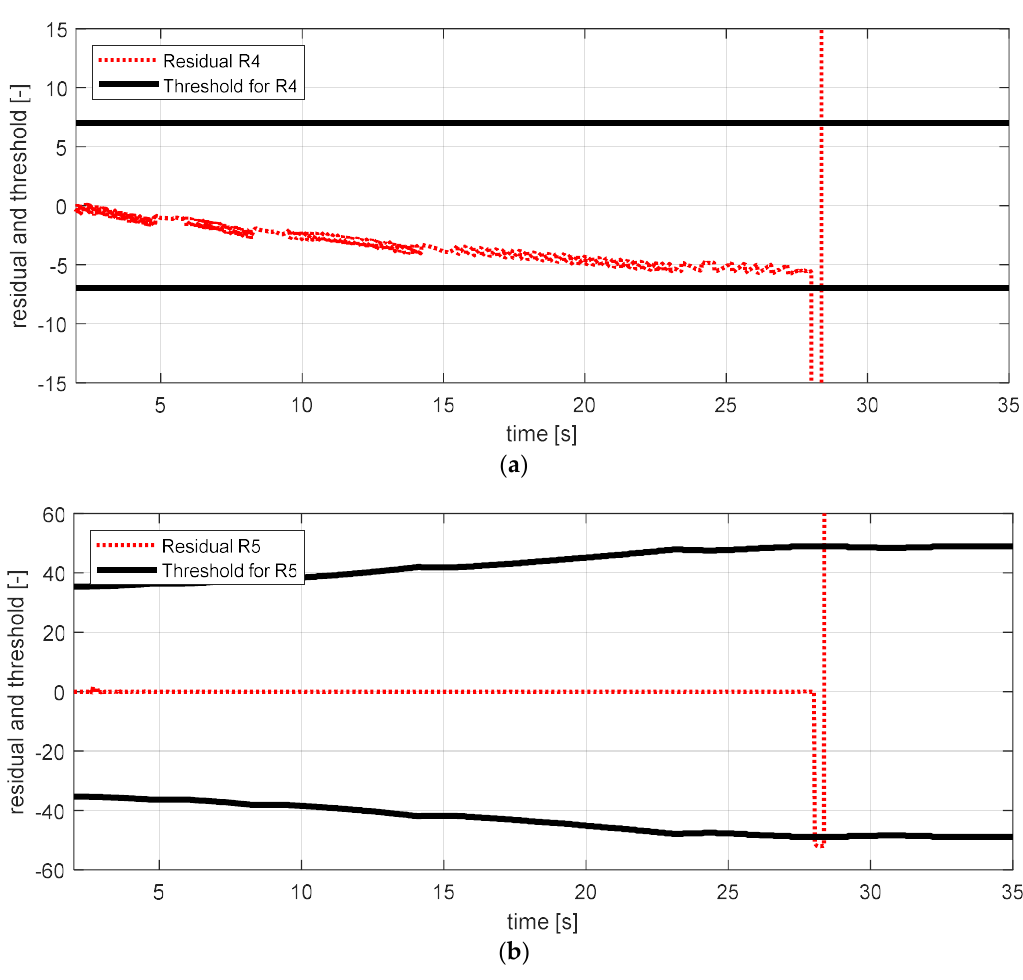
Figure 26. FDI simulation result for wheel angular speed sensor—rr (fault). ( a ) Residual 4 and threshold; ( b ) residual 5 and threshold.